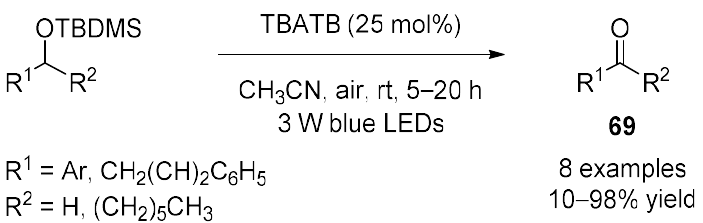
Figure 20. Results obtained in the aerobic photo-oxidation of aliphatic alcohols to ketones 69 cata- lyzed by 72